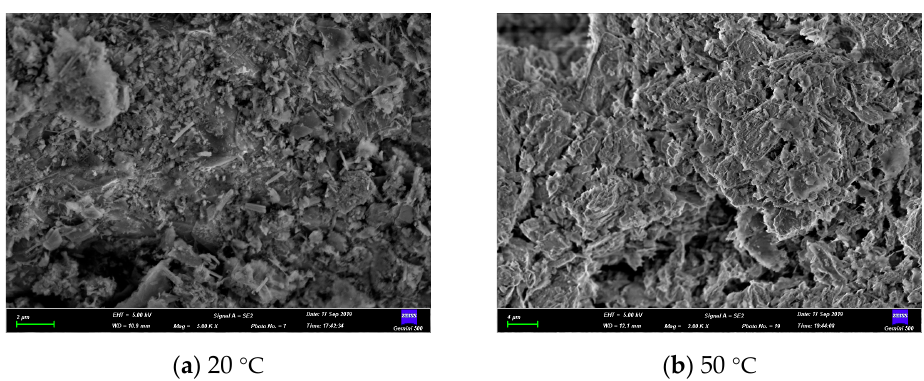
Figure 13. SEM images of samples at 28d under different temperature conditions.